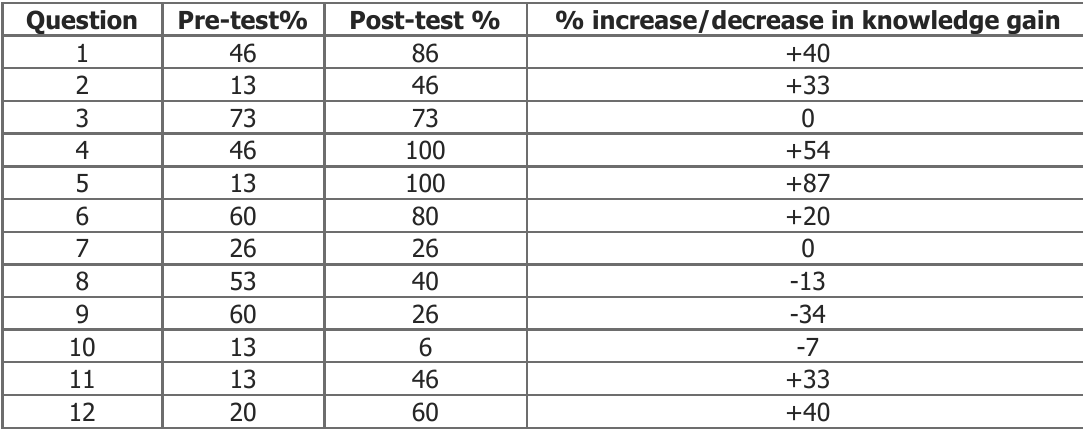
Knowledge Gain Pre-test Compared to Post-test for Iraqi 4-H Leader